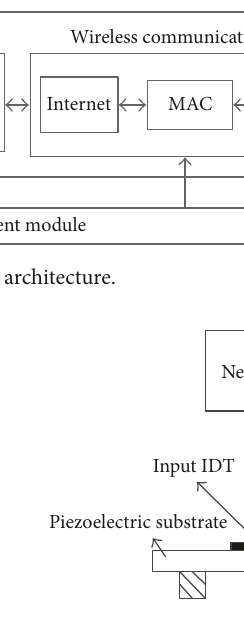
Figure 3: Schematic of the double-ended fixed sheet.